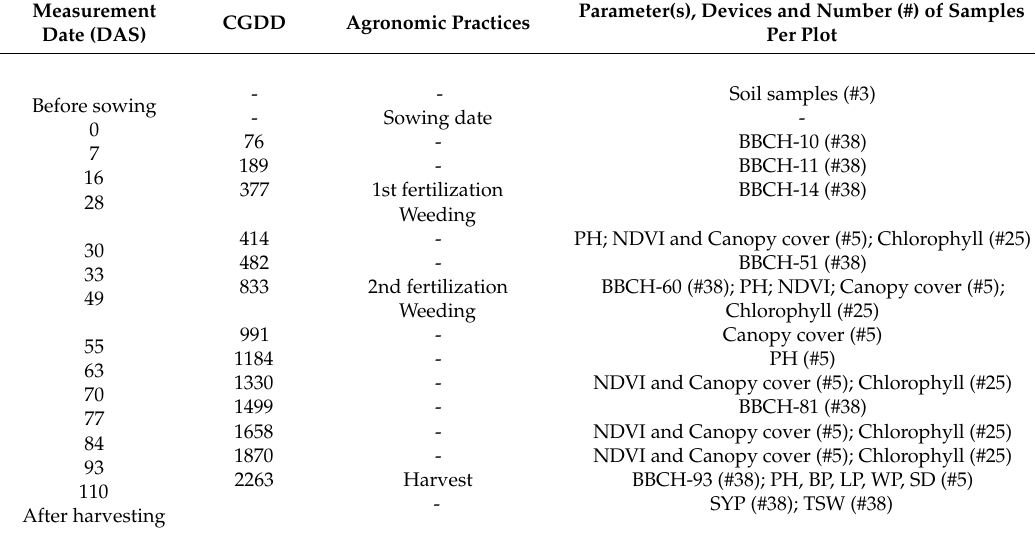
Table 1. Flowchart of agronomic activities as days after sowing (DAS) and cumulative growing degree days (CGDD), parameters measured, and number of